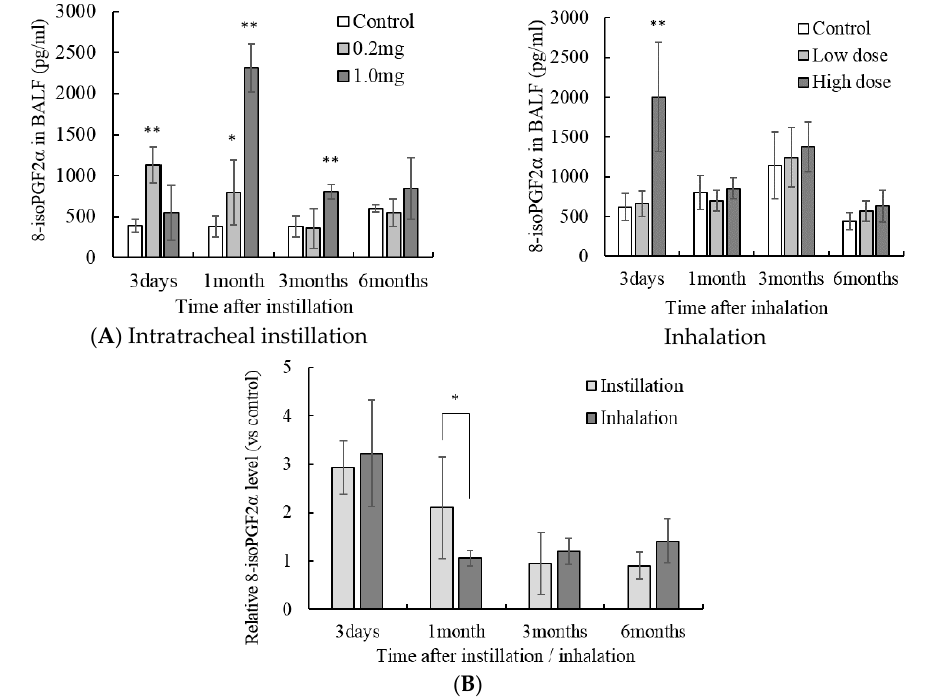
Figure 3. Influence of NiO nanoparticle exposure on the concentration of 8-iso-prostaglandin F2 α in the bronchoalveolar lavage fluid (BALF). ( A ) The concentration of 8-iso-prostaglandin F2 α in the BALF after intratracheal instillation and inhalation. The 8-iso-prostaglandin F2 α concentration was measured using ELISA. Values are mean ± SE ( n = 5). Significant differences versus control group are indicated in the figure (ANOVA, Dunnet). ** p < 0.01, * p < 0.05. ( B ) Comparison of 0.2 mg intratracheal instillation and high dose inhalation. The data show the relative level of the 8-iso-prostaglandin F2 α concentration against each control group. * p < 0.05 (ANOVA, Tukey).